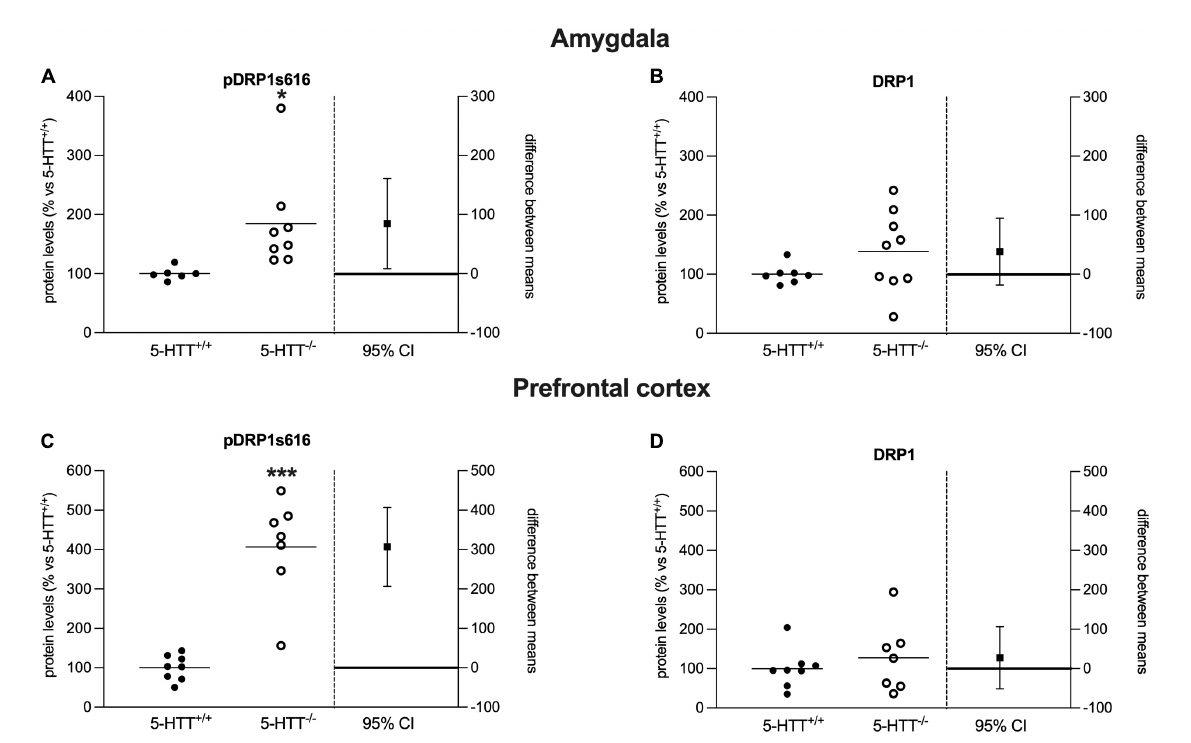
FIGURE3 Analysis of DRP1 (phospho Ser616, total) protein levels in the amygdala (A,B) and in the prefrontal cortex (C,D) of 5-HTT + / + and 5-HTT − / − rats. The results are represented as Gardner–Altman plots. The black square shows the difference between the two means, and the error bar shows the 95% confidence interval of that difference. The data are expressed as a percentage of 5-HTT + / + (set at 100%) of 6 to 10 independent determinations. * p < 0.05, *** p < 0.001 vs. 5-HTT + / + (Unpaired t